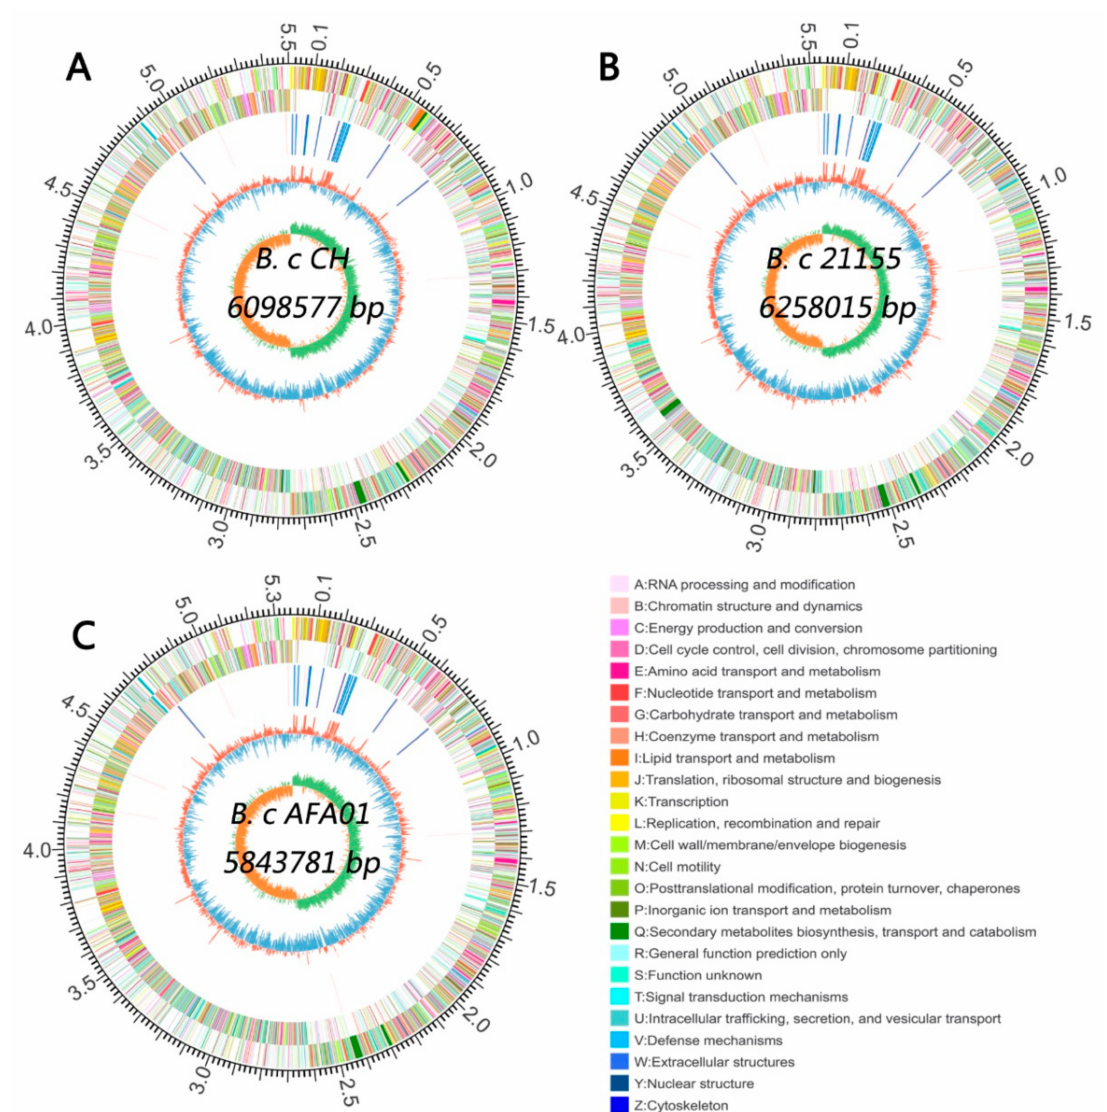
Figure 5. Genome map of B. cereus CH ( A ), B. cereus 21155 ( B ) and B. cereus AFA01 ( C ). Rings from the outside as follows: (1) scale marks (unit, Mb), (2) protein-coding genes on the forward strand colored by COG category, (3) protein-coding genes on the reverse strand (same color scheme as the second circle), (4) rRNA and tRNA genes, (5) GC content (deviation from average), and (6) GC skew in orange (below average) and green (above